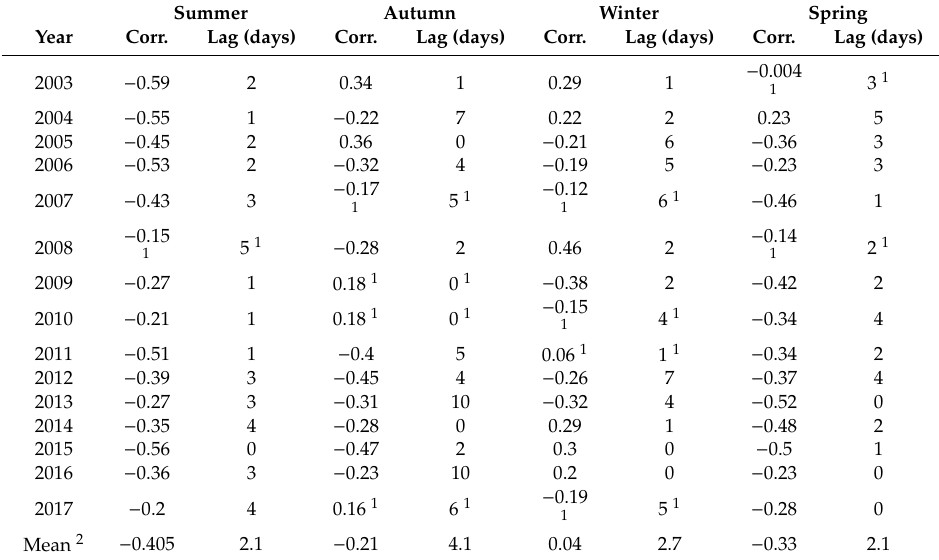
Table 1. Cross-correlation between daily SST anomalies north of the Punta Galera (~39.25 ◦ S, Figure 3, rectangle white 1) and alongshore SSW daily anomalies closest to Punta Galera (~40 ◦ S, Figure 3, rectangle white 2), per year and